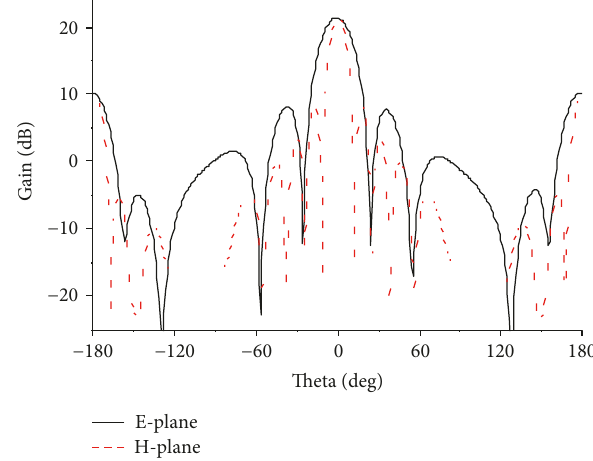
Figure 8: Simulation result of antenna skin